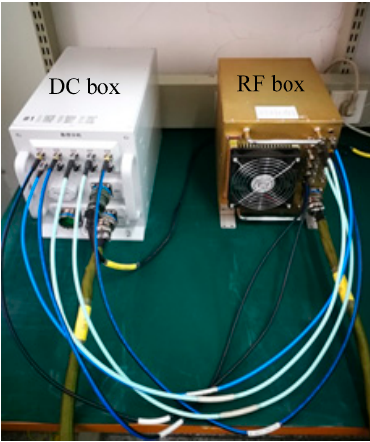
Figure 9. Outer view of the integration of the radio frequency (RF) box and digital control (DC) box on the table.